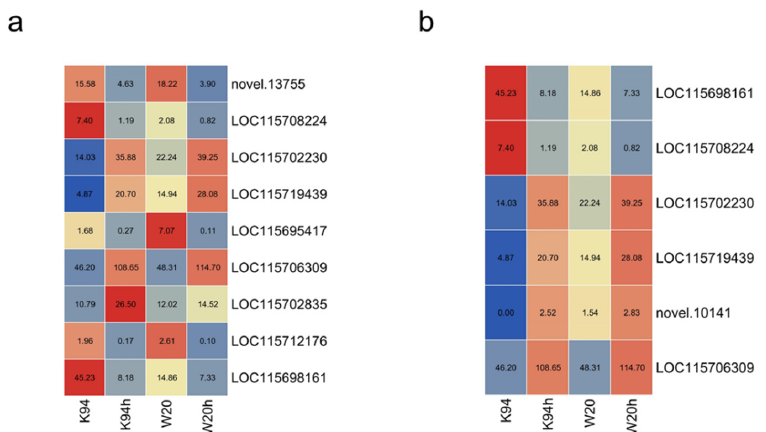
Figure 6. The heatmap of the expression profiles of DEGs which are related to plant hormone signal transduction ( b ) and the plant MAPK signaling pathway ( a ) in K94 after salt treatment. The scale bar indicates upregulated (red) and downregulated (blue) DEGs. The darker the color, the higher the expression; the lighter the color, the lower the expression.